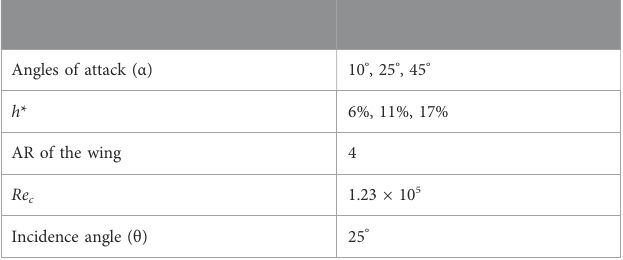
TABLE 1 The geometric parameters, kinematic parameters, and the relative dimensionless parameters of the test